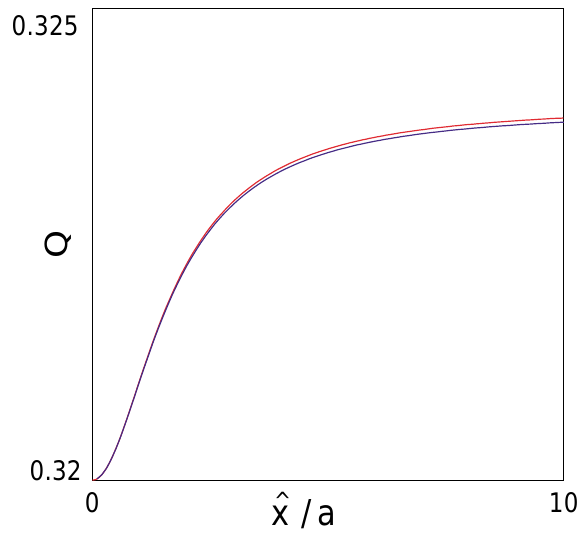
FIG. 7. (Color) Nonlinear tune ( Q (cid:1) V (cid:1) 2 p ) analytically com- puted (blue line), by canonical nonresonant perturbation theory, as a function of ˆ x (cid:1) a with ˆ p (cid:1) 0 ( 2 ; (cid:1) ˆ x 2 ) for ˆ j (cid:1) 0.05 and linear frequency v (cid:1) 0.32 3 2 p . The result is compared with the tune obtained by fast-Fourier transform (FFT) from tracking (red line).